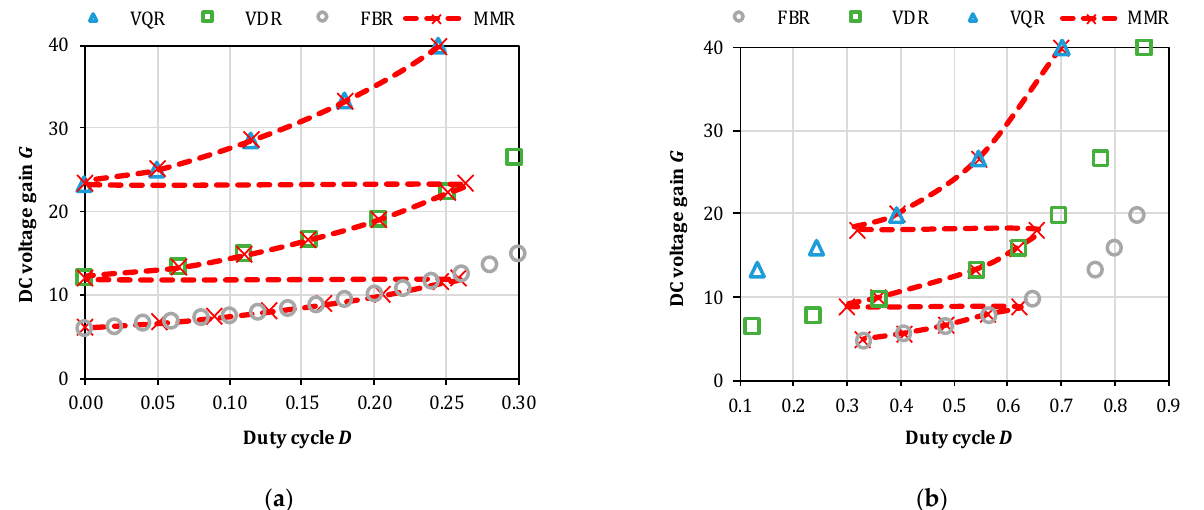
Figure 8. Experimental control variables vs. dc voltage gain and control trajectory of the MMR in the case of ( a ) FBqZSI and ( b ) BHBI. Table 4. Specifications of the experimental prototype.